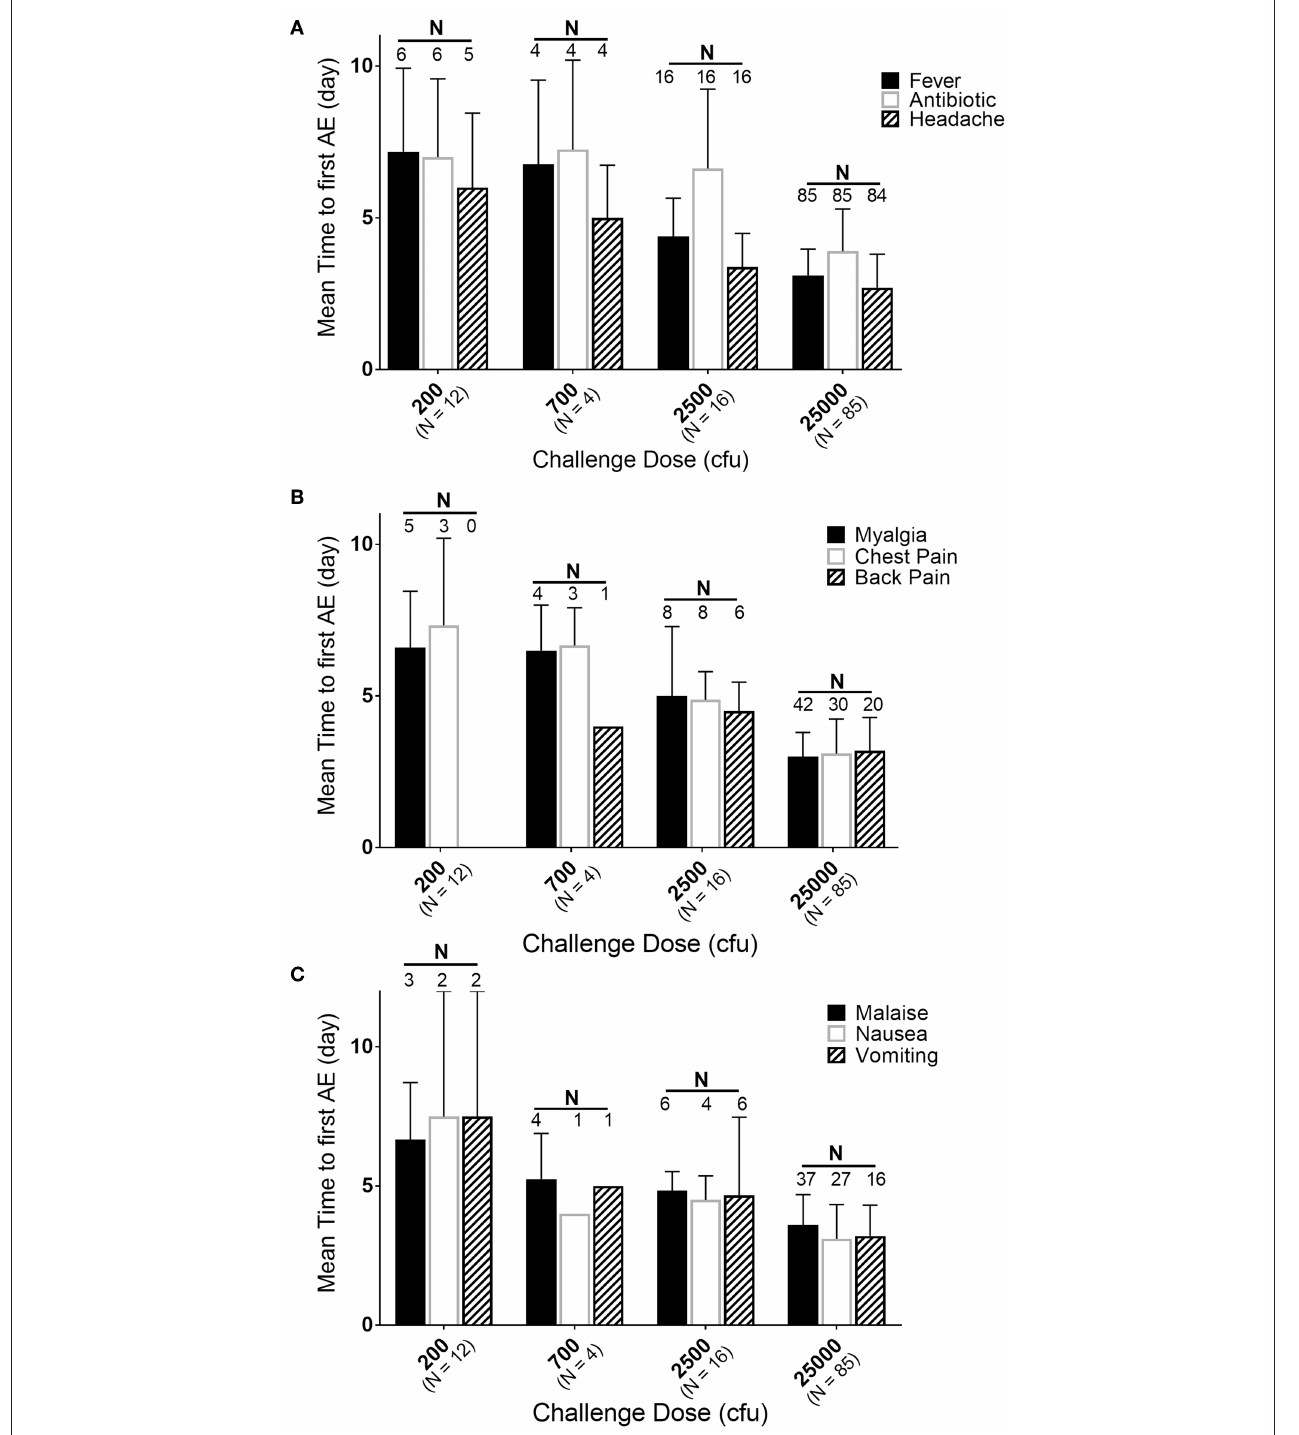
FIGURE 4 | Relationship of mean time to adverse event onset to exposure dose. Mean day ( ± SD) of first reporting of Adverse Events upon challenge with indicated doses of F. tularensis Schu S4. (A) Represents those in the majority or all of subjects, (B) represents AEs present in about half of subjects and (C) those in about 30% of subjects. Number of subjects exposed are indicated with dose, while the number of subjects that had a particular AE are labeled above the respective bars. Fever is calculated in hours and back-calculated to days, while other AEs and antibiotic administration are only reported by day of study. Note that only 50% of subjects exposed to 200 cfu experienced fever. Any of those exposed to 200 cfu that did not get fever, also did not get treated with antibiotic and only one developed antibodies by agglutination microtiter.